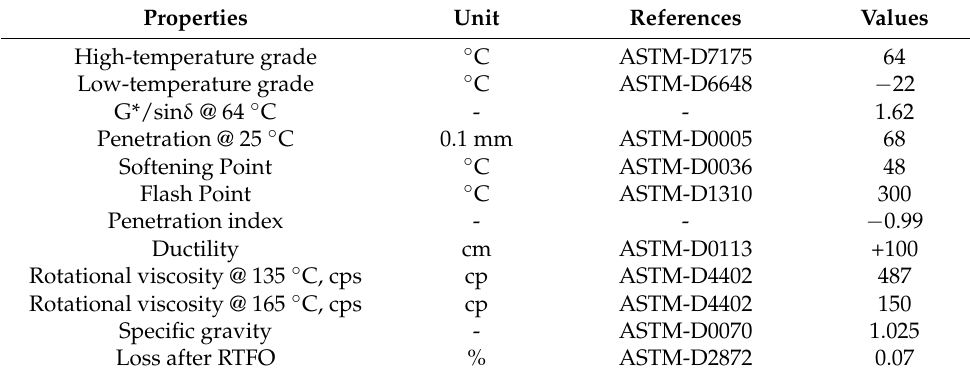
Table 1. Properties of asphalt